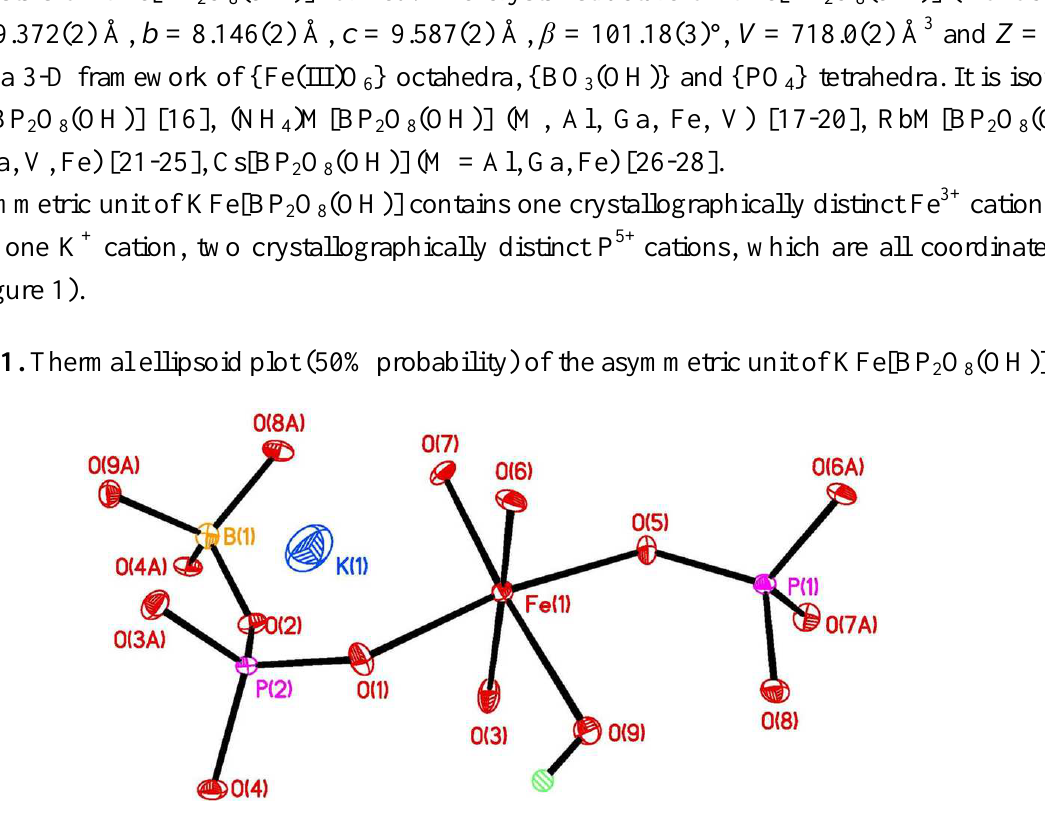
Figure 1. Thermal ellipsoid plot (50% probability) of the asymmetric unit of KFe[BP